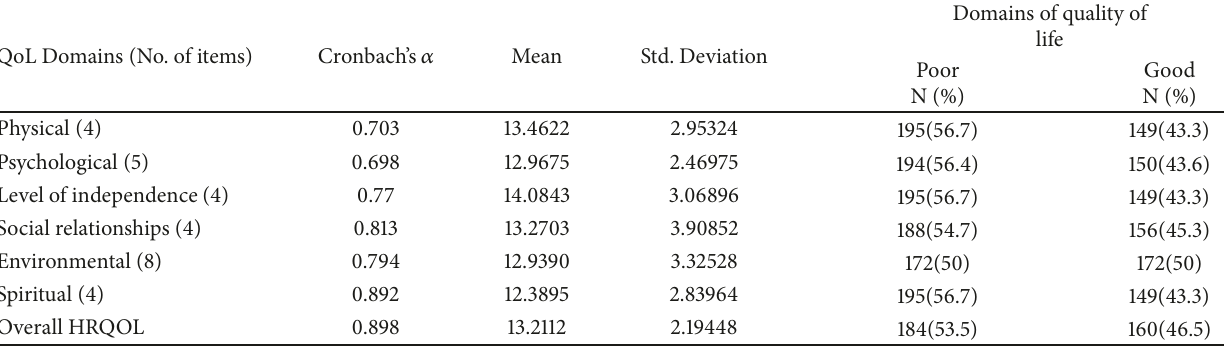
Table 2: HRQoL domains’ mean score of women on ART in Jimma town health facilities, 2016 (n = 344).